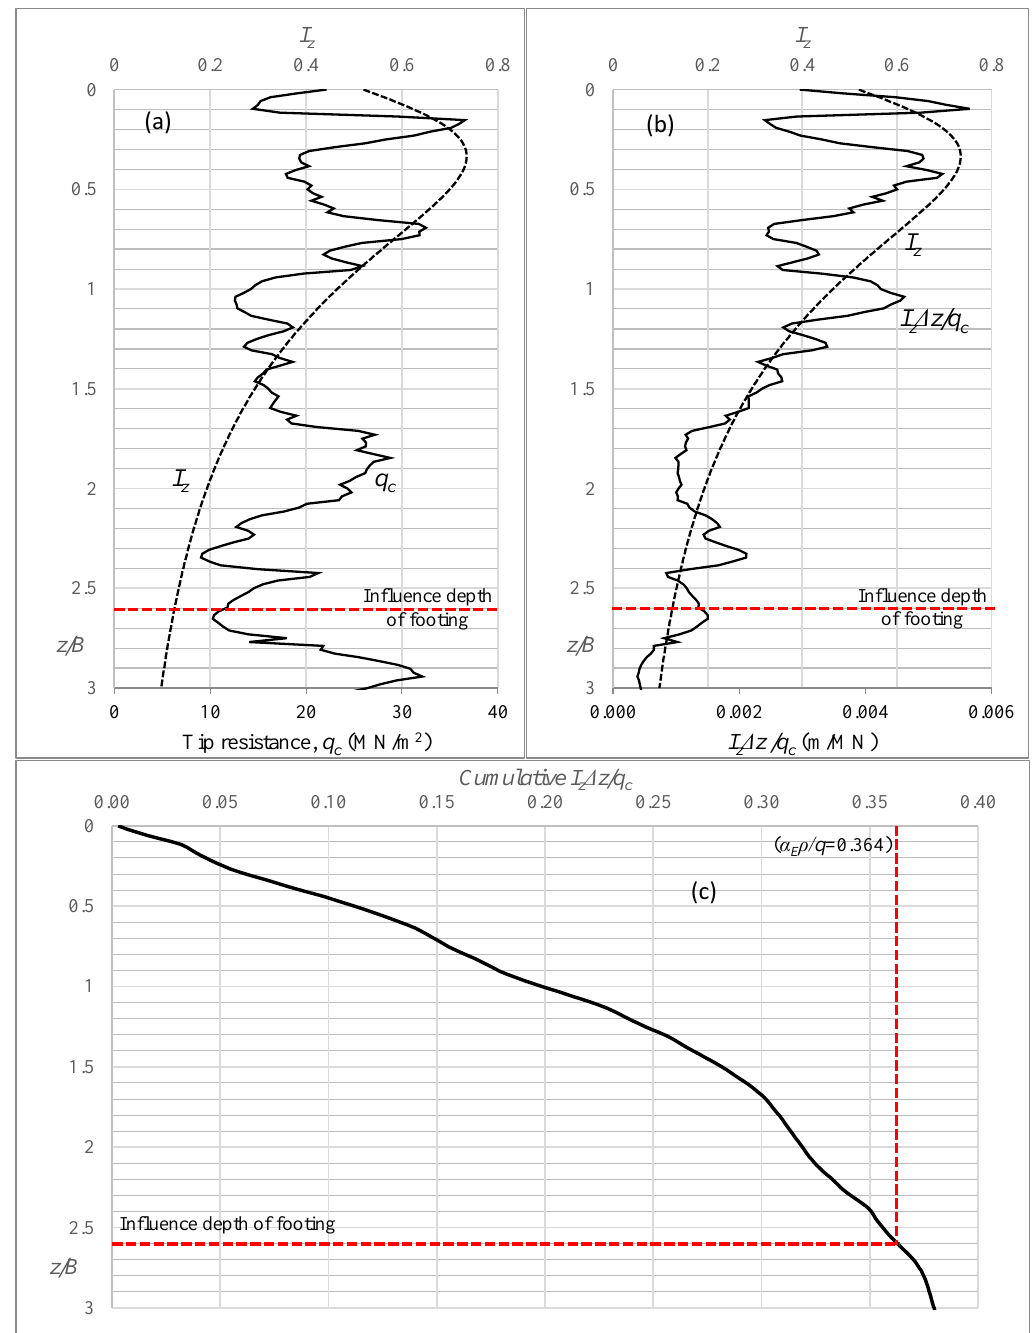
Figure 13. C harts referring to the application example: ( a ) I z – z/B and q c – z/B curves, ( b ) I z Δz/ q c – z/B and Figure 13. Charts referring to the application example: ( a ) I z – z / B and q c – z / B curves, ( b ) I z ∆ z / q c – z / B and I z – z/B curves and ( c ) cumulative I z Δz/ q c – z/B curve. I z – z / B curves and ( c ) cumulative I z ∆ z / q c – z / B